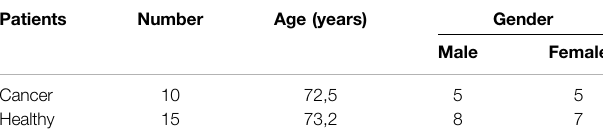
TABLE 1 | Demographic characteristics of patients included in the